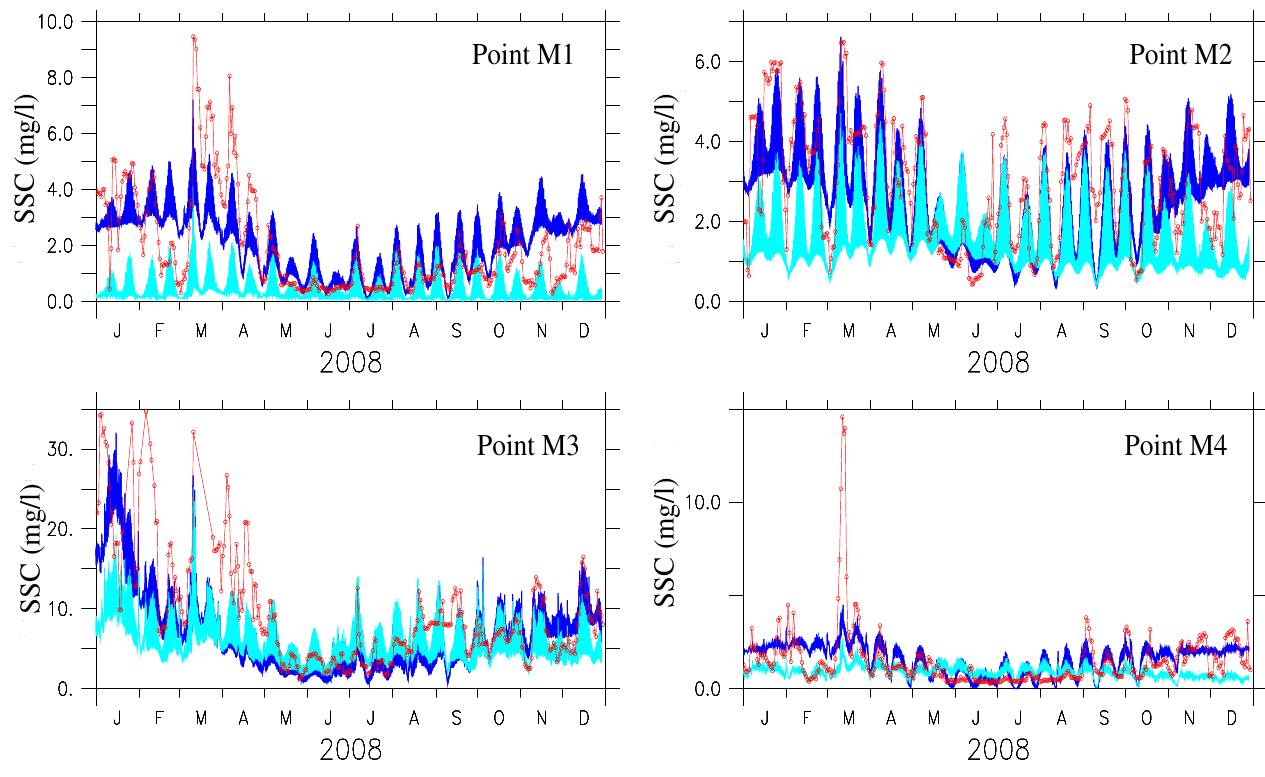
Figure 5. Time series of near-surface concentrations (red line) observed and predicted in Configurations (light blue line) A and (blue line) E at Points M1–M4 in 2008.